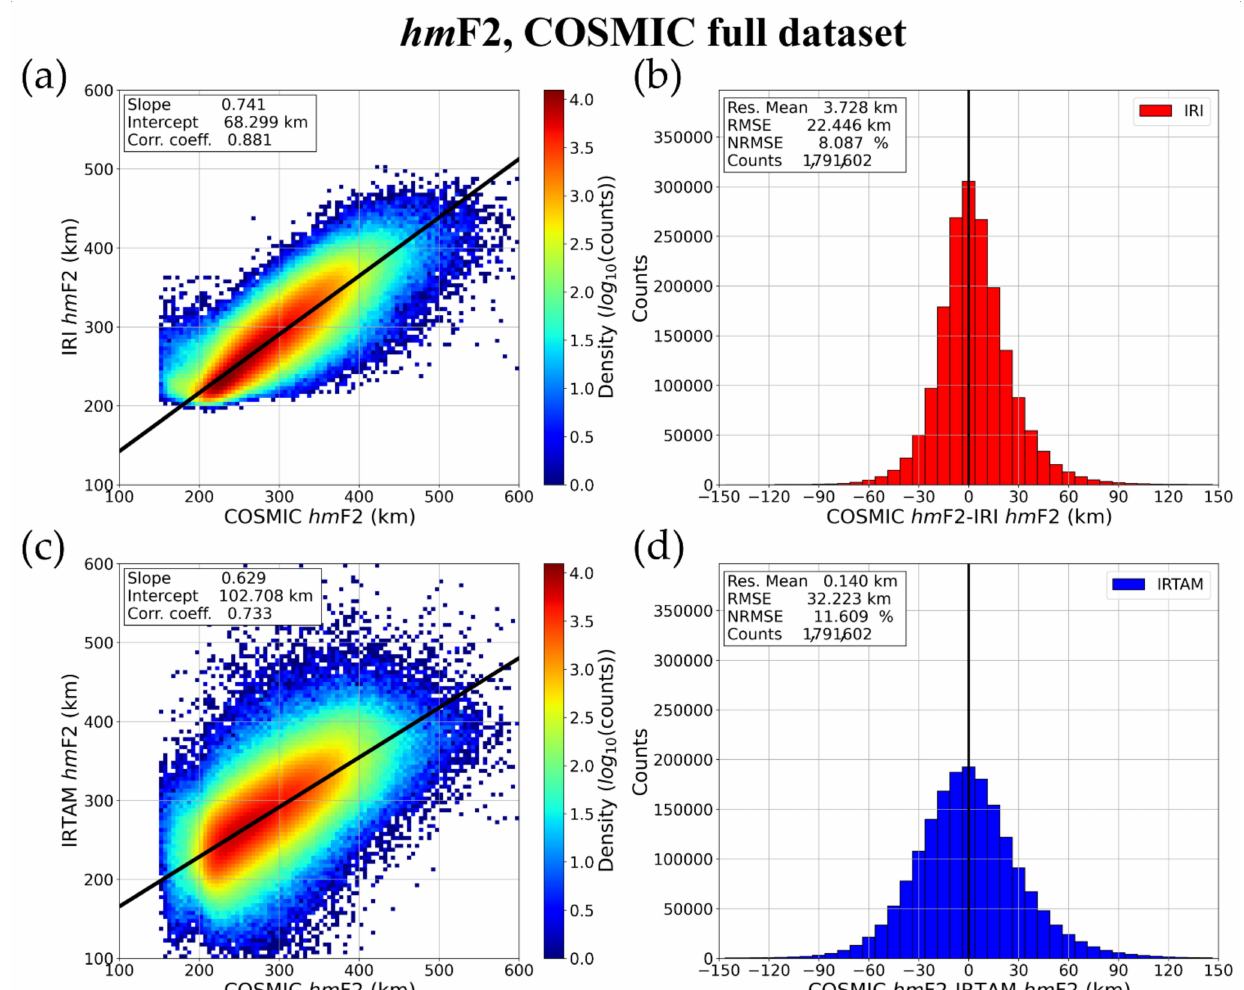
Figure 40. Density plots between measured ( x -axis) and modeled ( y -axis) hm F2 values, for ( a ) IRI and ( c ) IRTAM. Measured values are those from the entire COSMIC dataset. The black solid lines represent the best linear fit. Corresponding slope and intercept values, along with the correlation coefficient, are reported in the upper left box of each plot. Statistical distributions of the resultant residuals for ( b ) IRI and ( d ) IRTAM. Corresponding Res. Mean , RMSE , and NRMSE values, along with the total number of counts on which the statistics is based, are reported in the upper left box of each